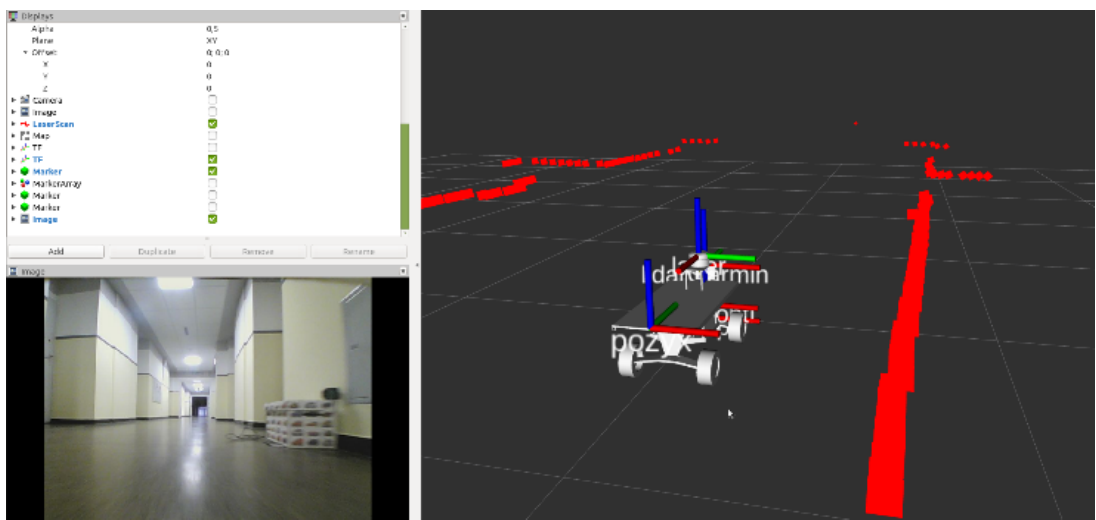
Figure 9. The visualization of the lidar scan points cloud and the generated map of the examined corridor using RviZ tool.